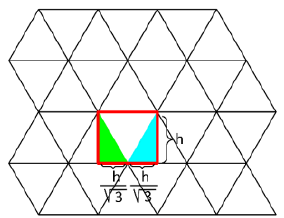
Figure 5. Triangular cells grid coordinates